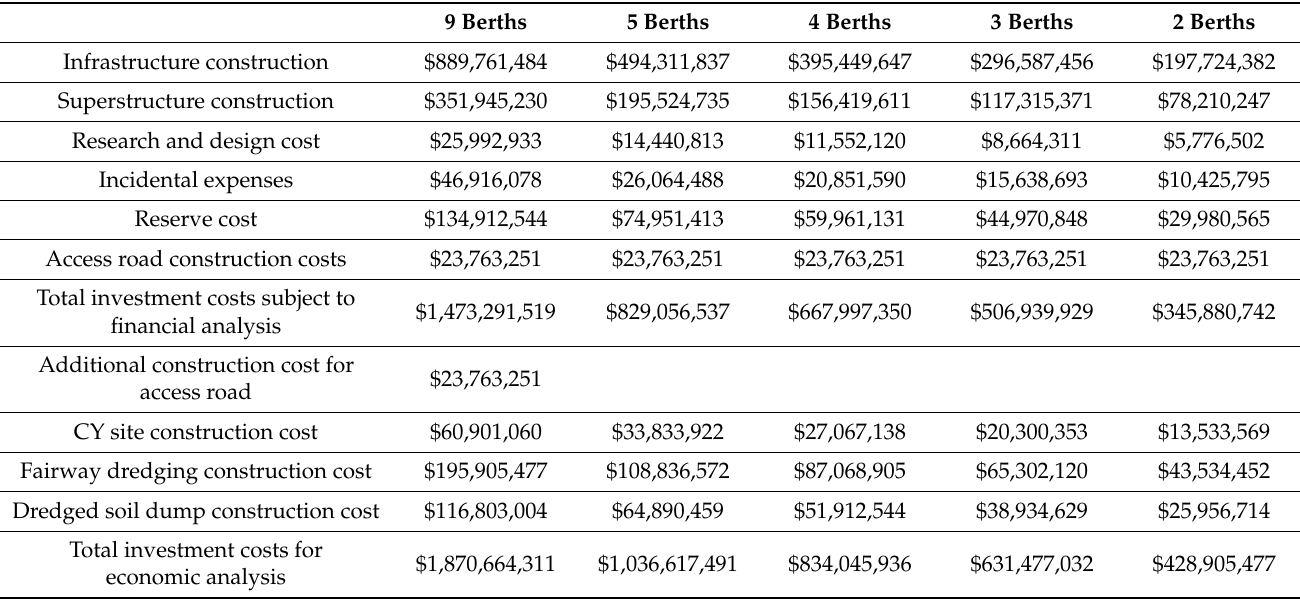
Table 11. Construction costs (units: U.S.